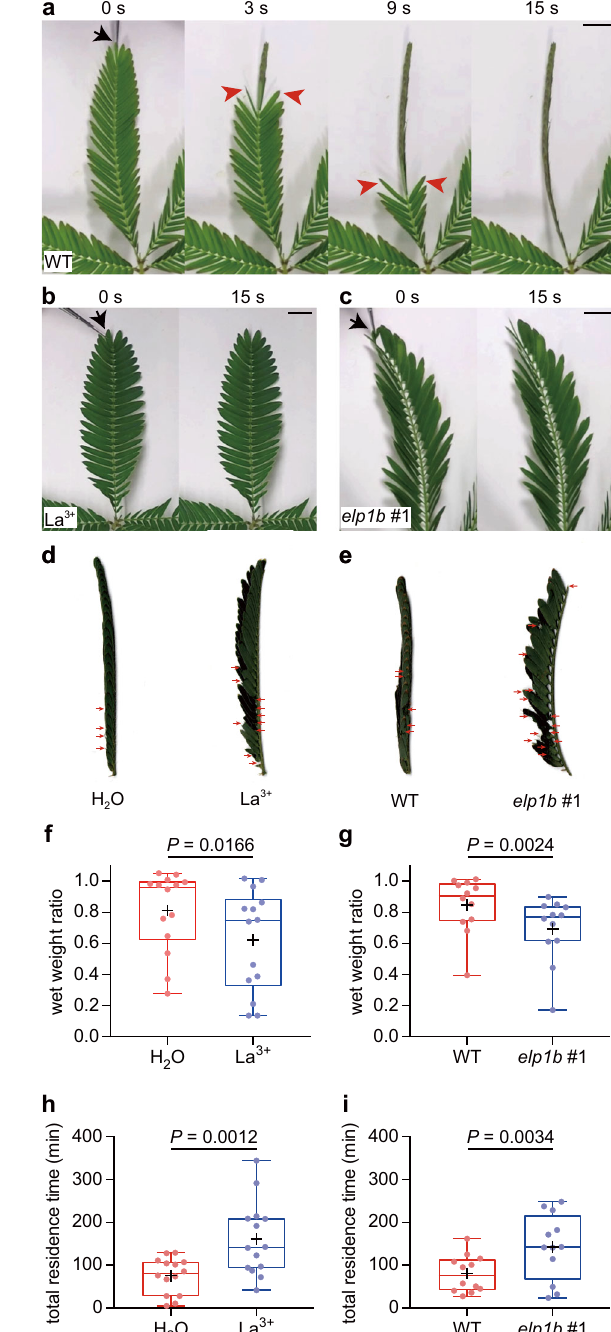
Fig. 3 | Immotile M. pudica is more vulnerable to attacks by grasshoppers. a – c Wounding (black arrows, 0s) caused lea fl et movements (red arrowheads) in wild-type (WT) leaves ( a ) but not in La 3+ -treated ( b ) and elp1b1elp1b2 ( elp1b #1, c ) leaves. d , e Herbivory damage (red arrowheads) in H 2 O- (control) and La 3+ -treated pinnae ( d ) and WT and elp1b1elp1b2 pinnae ( e ). f , g La 3+ -treated leaves ( f ) and elp1b1elp1b2 leaves ( g ) were more consumed by grasshoppers than control/WT leaves. h , i Total residence time of grasshoppers on the control and La 3+ -treated leaves ( h ) and the WT or elp1b1elp1b2 leaves ( i ) n =14 independent leaf pairs for f and h , and n =12 independent leaf pairs for g and i . The boxes show the inter- quartile ranges, and the whiskers show the minimum and maximum values. The horizontal lines within the boxes and the plus signs indicate the medians and means, respectively. The dots represent individual data. Statistical analyses were performed using a two-tailed Wilcoxon matched-pairs signed rank test. Scale bars, 10mm.